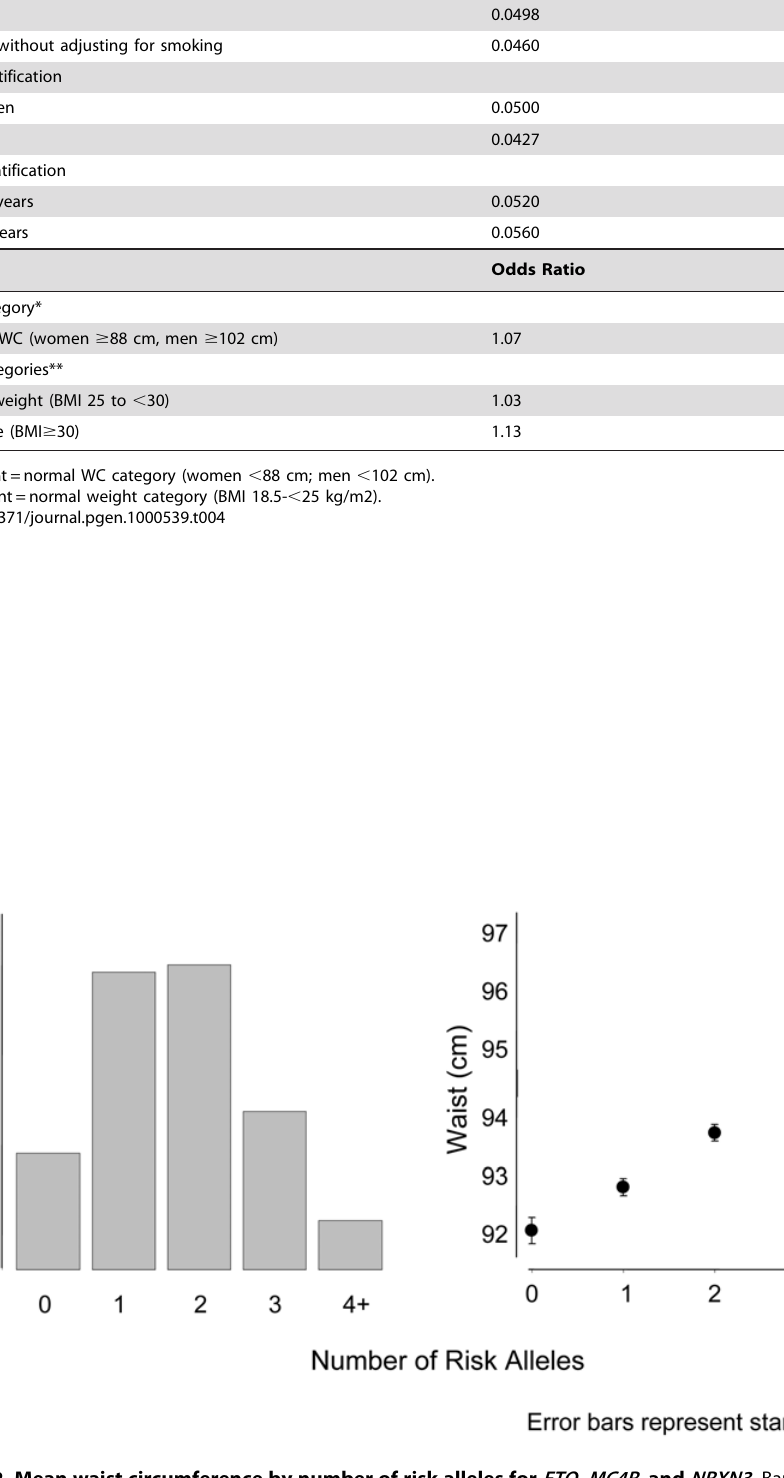
Figure 2. Mean waist circumference by number of risk alleles for FTO , MC4R , and NRXN3 . Bars represent standard errors. The panel on the left represents the distribution of risk alleles in the overall